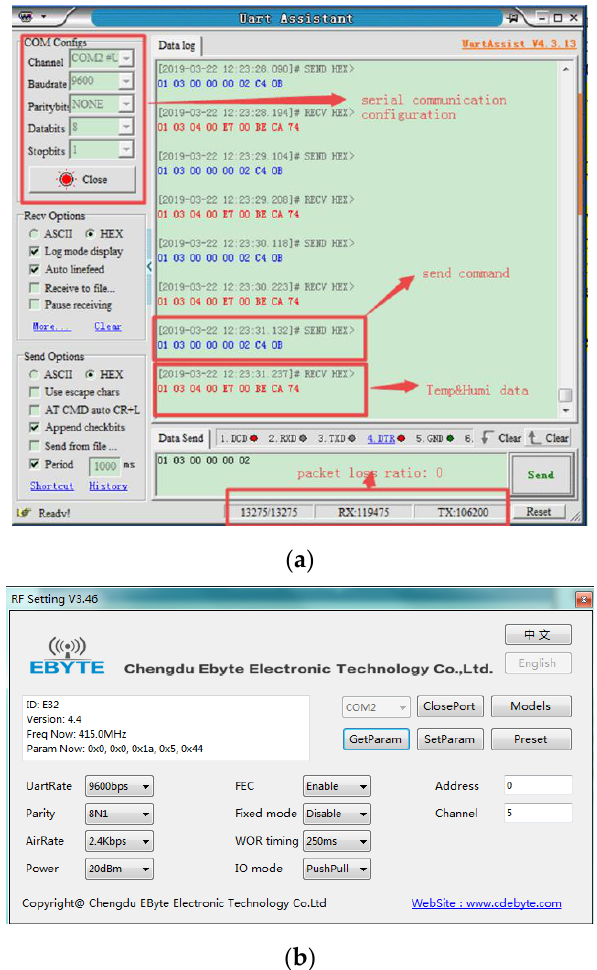
Figure 6. Software used in test: ( a ) measurement software [39] ; ( b ) configuration software [40].